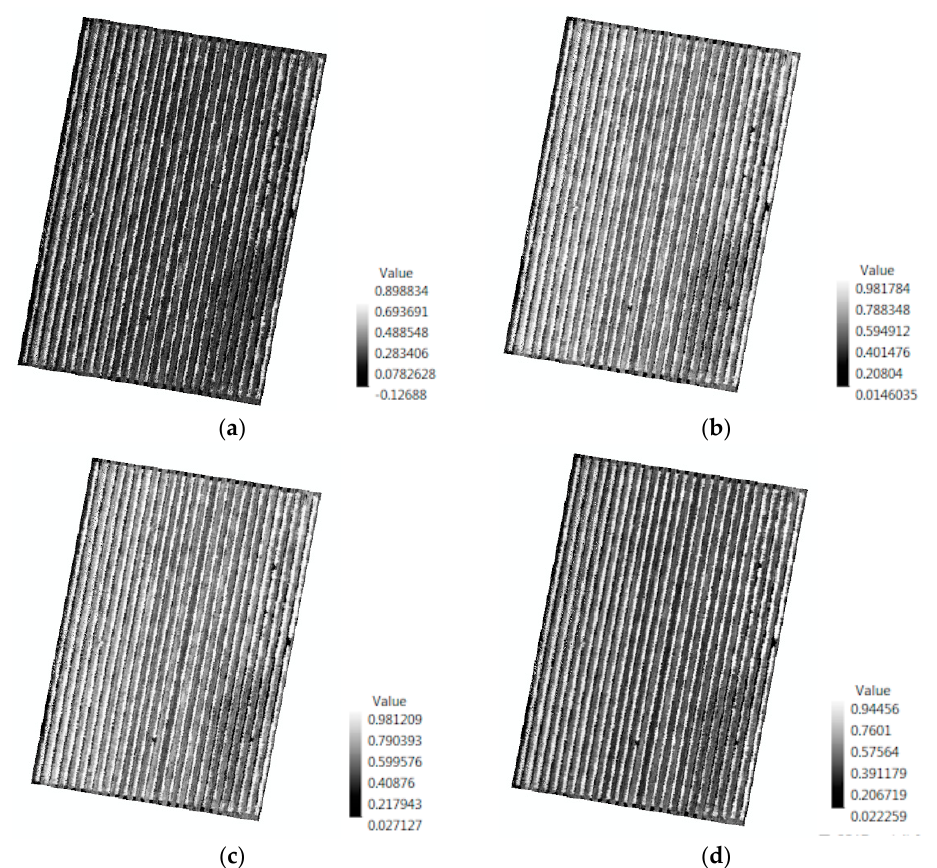
Figure 12. Vegetation indices for block 3 with the highest correlation to vigour assessment. ( a ) PI2; ( b ) PI5; ( c ) NDVI; and ( d ) OSAVI H . All of the indices are based on hyperspectral imagery collected in February 2017.